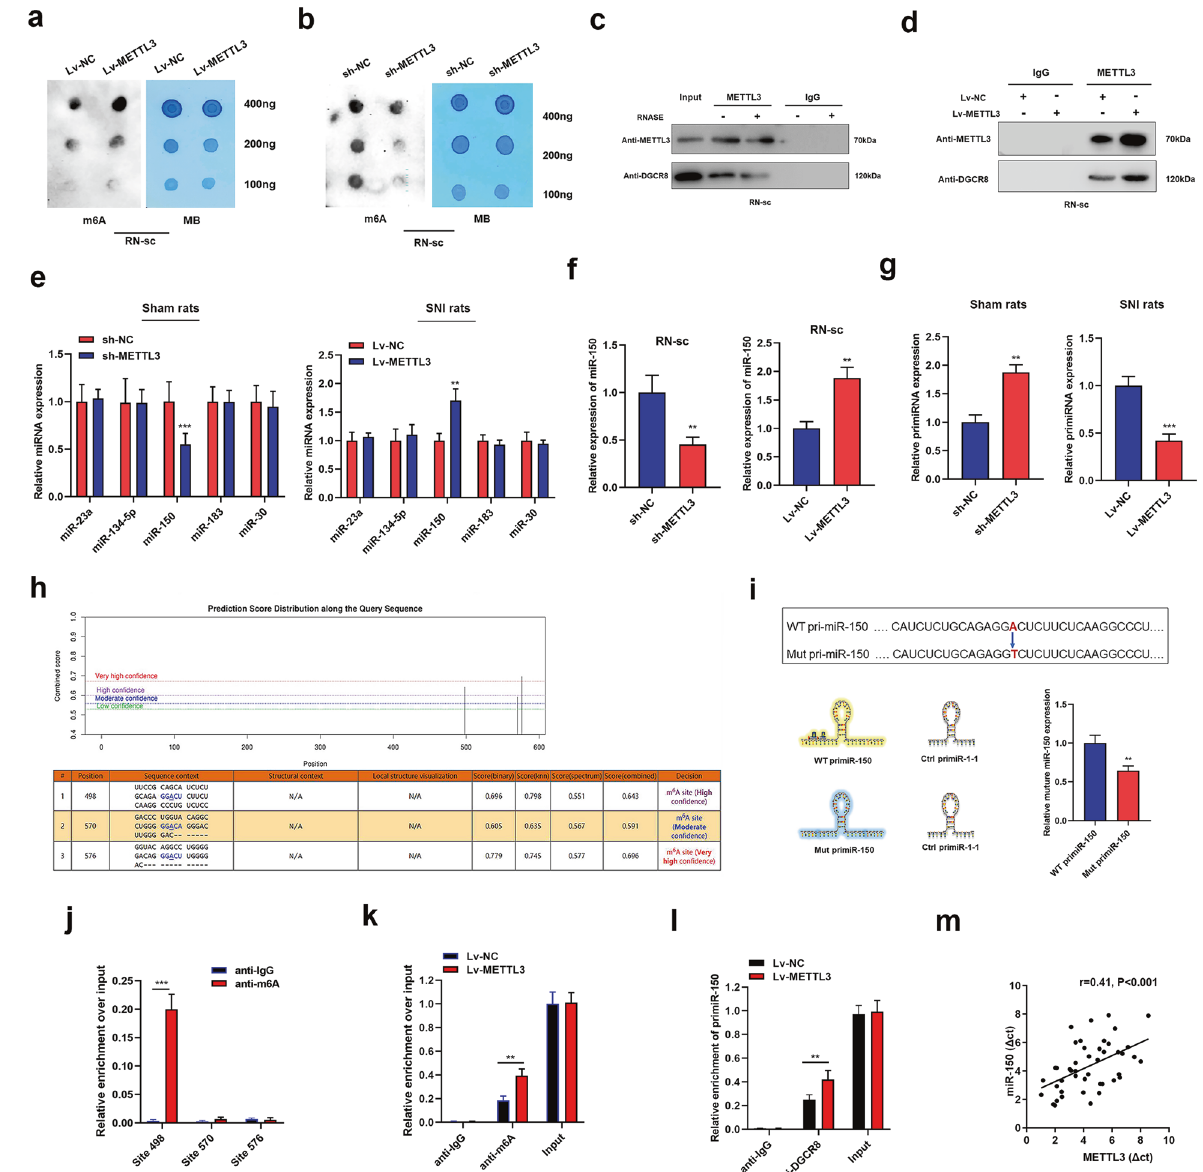
Fig. 3 METTL3 facilitates miR-150 maturation via binding with DGCR8. a , b m6A dot blot assays of m6A content in RN-sc cells that were overexpressed ( a ) or silenced with METTL3 ( b ). Results showed a clear positive regulation of METTL3 on m6A enrichment. c Co- immunoprecipitation assay was performed using indicated antibodies. The results showed that METTL3 was directly connected with DGCR8 protein. d Immunoprecipitation assay was conducted with antibodies against DGCR8 and METTL3. The RNA pulldown from METTL3 overexpressed cells and NC cells was shown. e The expression of putative miRNAs in spinal cord tissues upon dysregulation of METTL3. The obtained data showed that miR-150 was silenced by METTL3 knockdown in sham rats, whereas upregulated when METTL3 was overexpressed in SNI rats. ** P < 0.01, *** P < 0.001 in comparison with control groups. f miR-150 was detected in RN-sc cells upon silence or overexpression of METTL3. ** P < 0.01 compared with control groups. g PrimiR-150 was quanti fi ed via qPCR analysis in spinal cord tissues injected with sh- METTL3 (sham) and Lv-METTL3 (SNI). ** P < 0.01, *** P < 0.001 compared to control groups. h Potential targeted m6A sites in primiR-150 according to SRAMP online website. i Representation of the reporters constructed to con fi rm the functional role of METTL3 in miR-150 maturation. j Me-RIP assay showed a signi fi cant higher enrichment of m6A at site 498 compared with IgG control. N = 3 biological replicates. *** P < 0.001. k , l RIP assay with m6A antibody ( k ) and DGCR8 antibody ( l ) showed that the enrichment was increased upon METTL3 overexpression. N = 3 biological replicates. ** P < 0.01. m qPCR showed a positive correlation between METTL3 transcript and miR-150 in serum of 45 NP patients. The experiment was repeated three times with similar results.